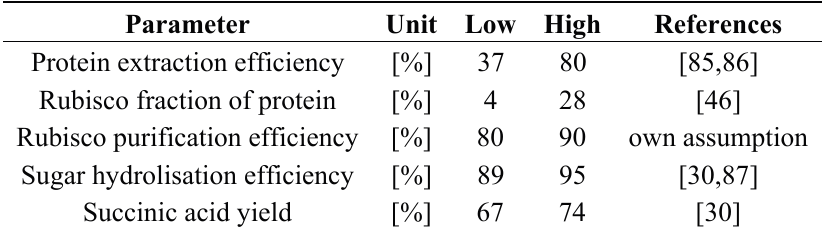
Table 3. Assumptions related to biorefinery